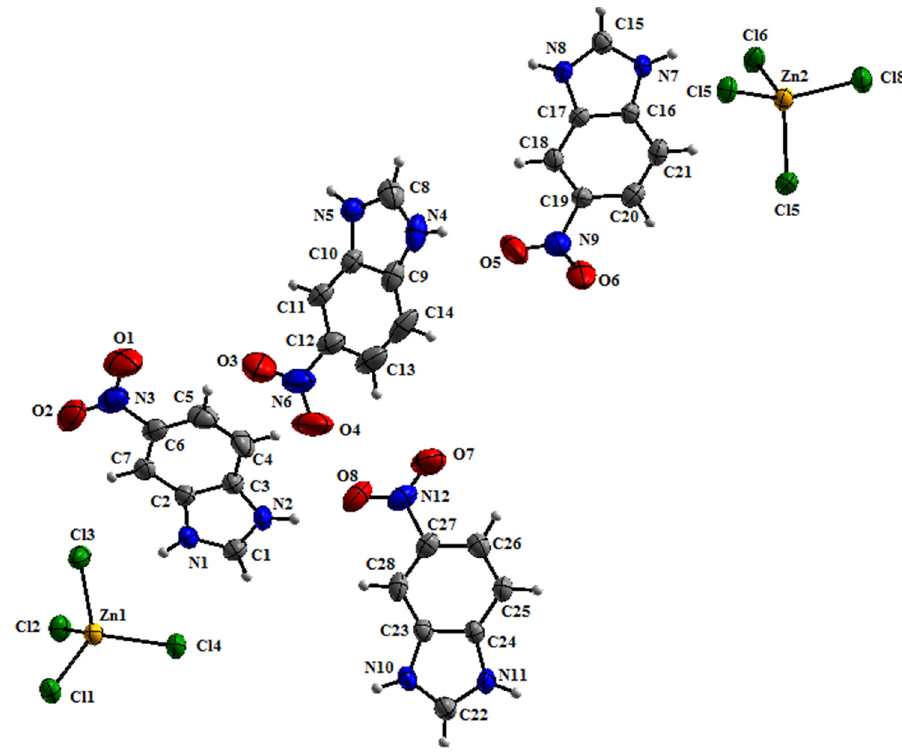
Figure 1. Crystal unit lattice of (C 7 H 6 N 3 O 2 ) 2 [ZnCl 4 ]. The solid-state arrangement of (C 7 H 6 N 3 O 2 ) 2 [ZnCl 4 ] can be described as an alternation between (C 7 H 6 N 3 O 2 ) + cations and tetrachlorozincate (II) entities. These entities are linked together through four types of H-bonds (Table S2 and Figure